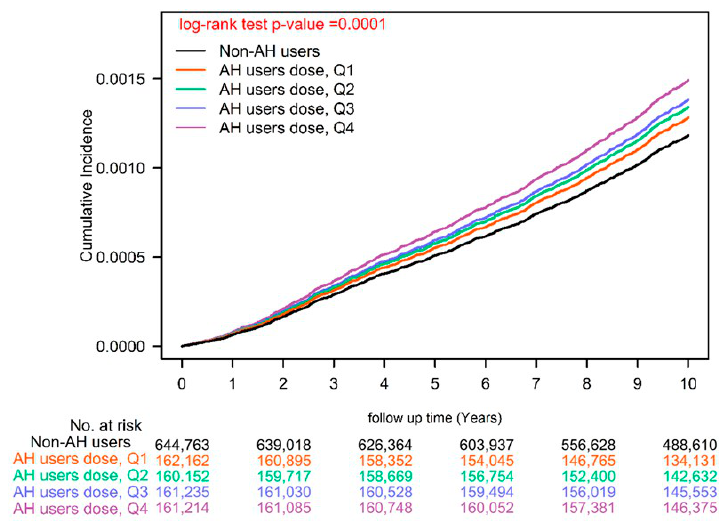
Figure 2. Kaplan–Meier cumulative incidence for ESCC at different cDDDs of AH use. AH, H1- antihistamine; ESCC, esophageal squamous cell carcinoma; cDDD, cumulative defined daily dose; Q, Quartile.